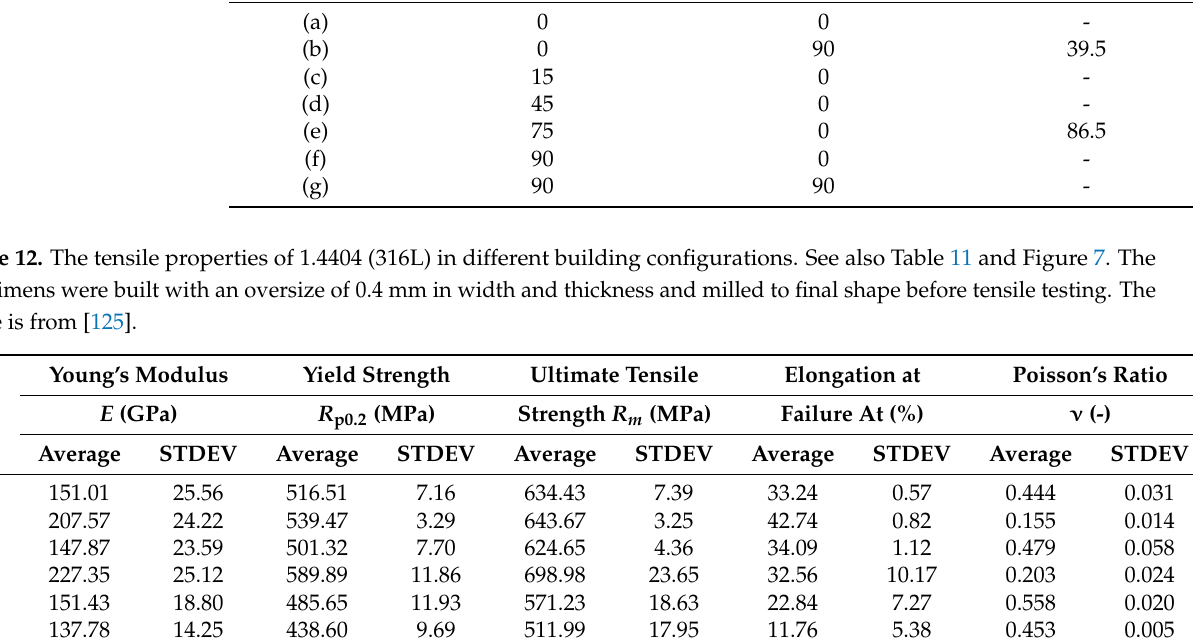
Table 11. The tested configurations. See also Figure 7 and Table 12. The table is from [125]. Config.